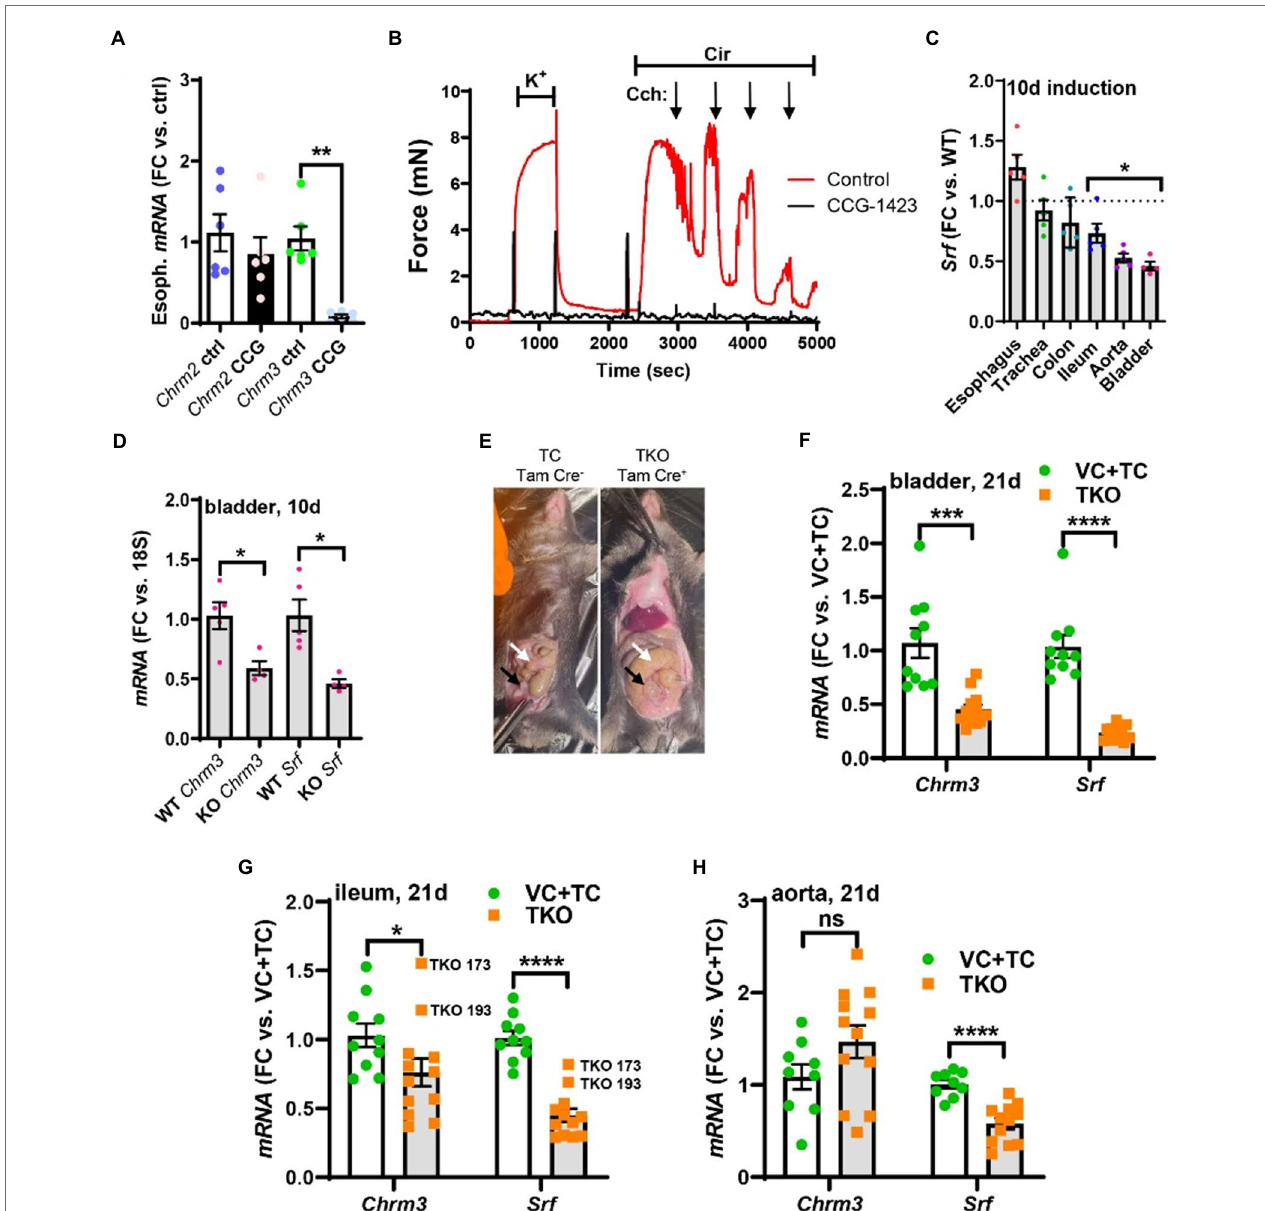
FIGURE 5 | Pharmacological inhibition of MRTF-SRF signaling in organ culture, and knockout of Srf in vivo , reduces M 3 receptor expression. To examine if MRTF- SRF signaling regulates muscarinic M 3 receptor expression in situ , we first isolated organs from wild-type C57Bl/6 mice. Organs were split in half and maintained for 96 h in organ culture with vehicle (DMSO) or CCG-1423 (10 μ M). A clear reduction of Chrm3 relative to the house-keeping gene 18 s was seen in the esophagus (A) , but in the remainder of the organs, the house-keeping genes examined declined (not shown). We also found that organ culture of the mouse caudal artery in the presence of CCG-1423 eliminated force development on stimulation with the α 1-adrenergic agonist cirazoline (B) , suggesting that this experimental paradigm is unsuitable for studying effects on endothelium-dependent dilatation. Mice with SMC-specific knockout of Srf were next obtained by injecting Srf fl/fl mice harboring the Myh11-Cre/ERT2 transgene with tamoxifen for 5 consecutive days (knockout: KO). Cre-negative Srf fl/fl mice injected with tamoxifen were used as controls (wild- type: WT). Organs were harvested and frozen 10 days after the first injection and transcript levels were determined by RT-qPCR. At this time, body weights were unchanged, but Srf depletion was seen in some organs (C) . (D) Shows that Chrm3 was reduced in parallel with Srf in the bladder, but this was not seen elsewhere (not shown). We therefore next used mice at 21 days post tamoxifen. Two control groups were included in this second experiment along with the tamoxifen-treated knockouts (TKO): vehicle-treated Cre-positive mice (VC) and tamoxifen-treated Cre-negative mice (TC). At 21 days, mobility on provocation was reduced, the intestines had started to swell [ (E) , white arrows], and the urinary bladders were often enlarged [ (E) , black arrows]. Both Chrm3 and Srf were reduced in the bladder (F) and ileum (G) . For the ileum, the two knockouts with the most modest Srf depletion (TKO 173 and TKO 193) are highlighted. No change of Chrm3 was seen in the aorta (H) , despite significant Srf depletion. These findings show that MRTF-SRF signaling is critical for Chrm3 expression in gastrointestinal and urogenital organs in vivo . *** p <0.001, ** p <0.01, and * p <0.05